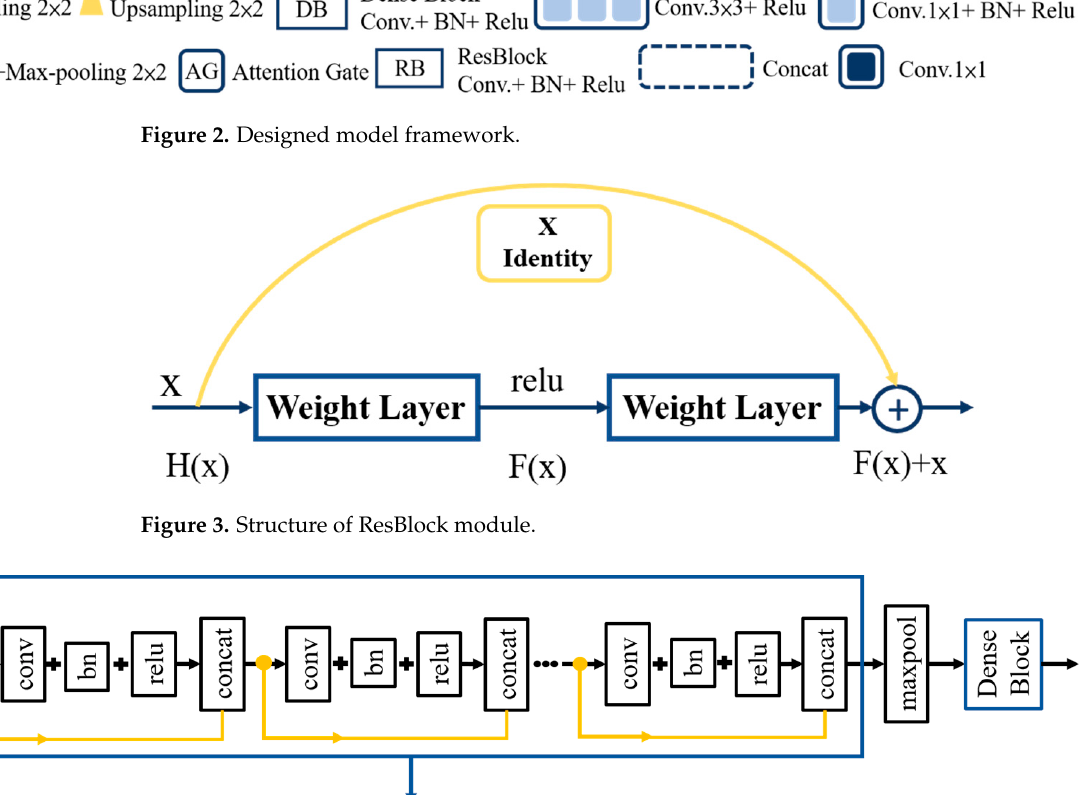
Figure 4. Detailed structure of DenseBlock.